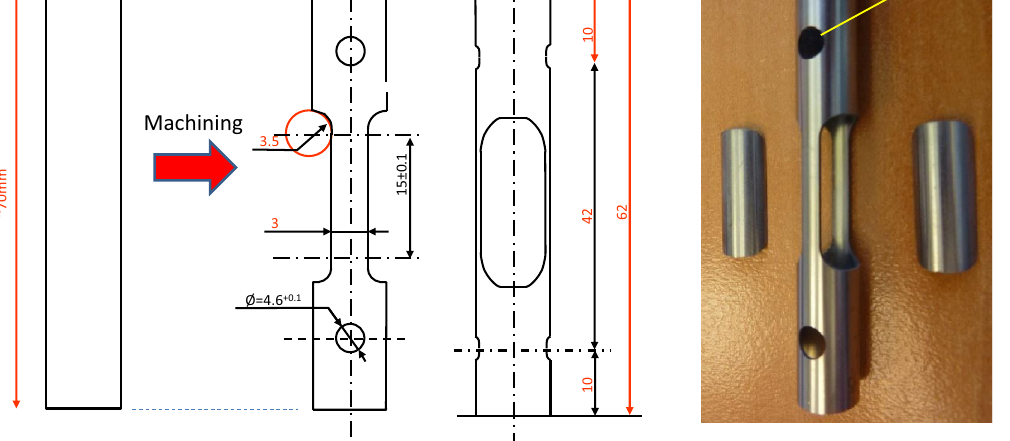
Fig. 1. Axial tensile sample geometry.